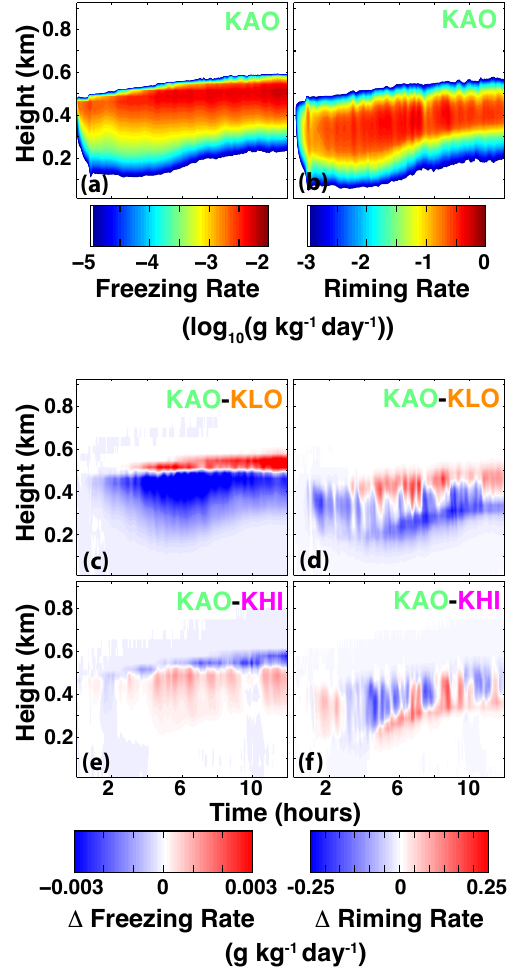
Fig. 15. An overview of droplet freezing and riming rates from sim- ulations assuming different aerosol concentrations. Illustrated are domain averaged time-height cross-sections of freezing (a) and rim- ing (b) rates for the simulations featuring SHEBA aerosol concen- trations as well as the differences between these domain-averaged values for the KAO simulation and simulations featuring lower (c, d) and higher (e, f) aerosol